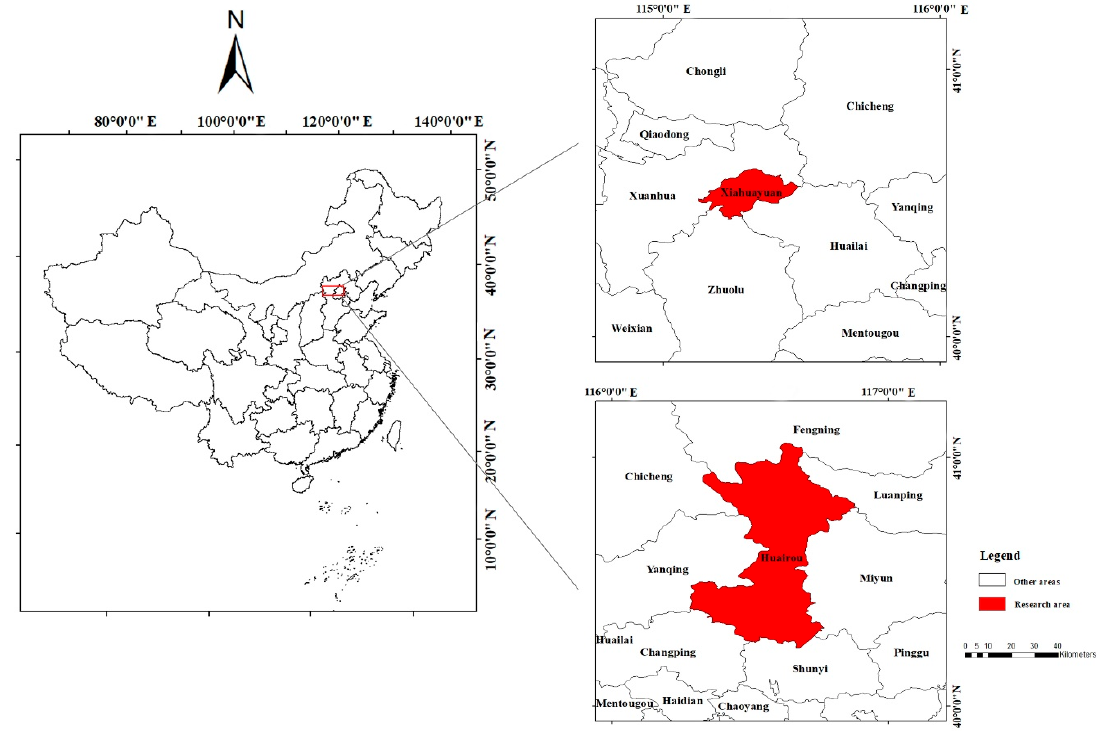
Figure 1. The study areas and their location in China.